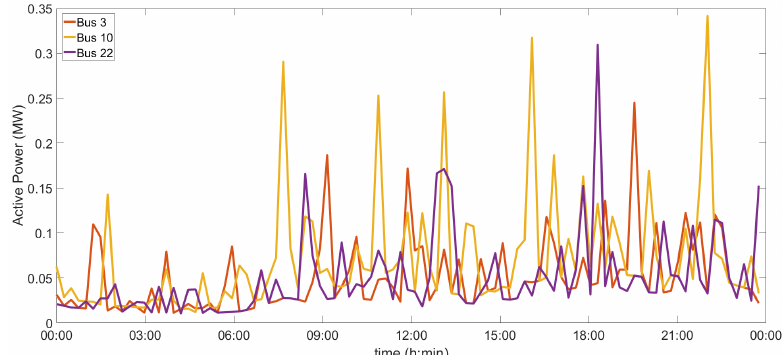
Figure 9. Daily load profiles of Buses 3, 10 and 22 of the 33 Bus System zoomed in.